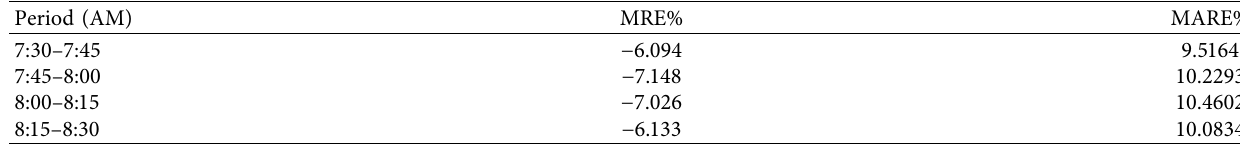
Table 3: MRE and MARE results for every 15min.